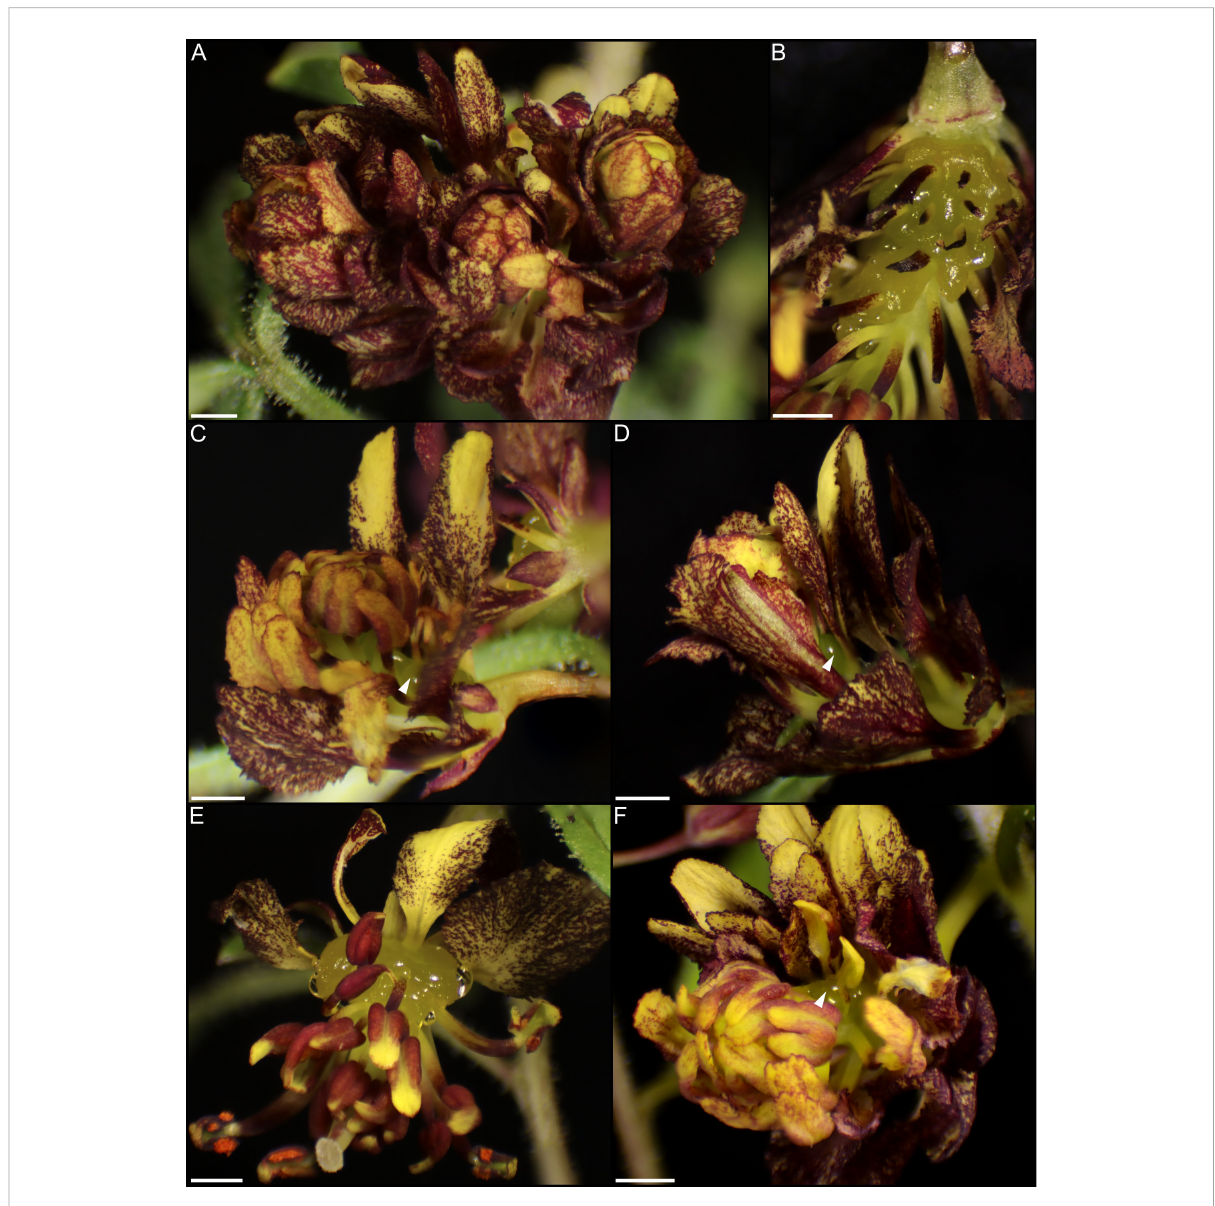
FIGURE 11 Flowers of Cleome violacea treated with pTRV2- CvAG constructs. (A) Flower with repeating perianth whorls. (B) Nectary from fl ower similar to A with petals removed. (C) Flower with normal adaxial petals, repeating perianth whorls and adaxial nectary. (D) Flower with repeating perianth whorls and distally positioned nectary. (E) Flower with petaloid stamens and adaxial nectary. (F) Flower with repeating perianth whorls and adaxial nectary. White arrowheads indicate nectary position. Scale bars = 1